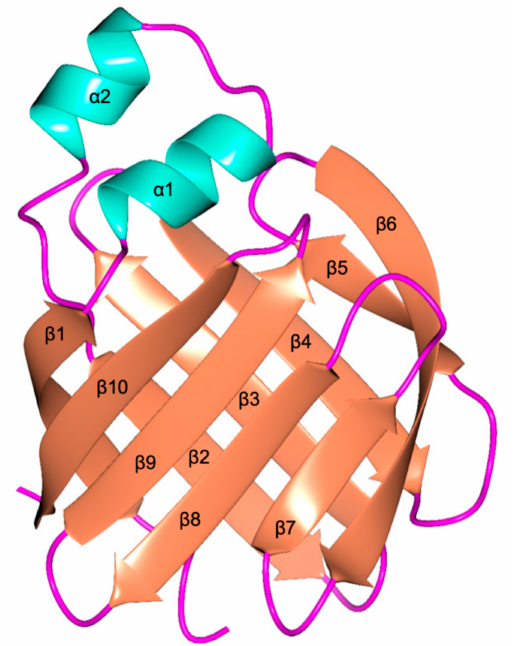
Figure 4. Cartoon representation of the tertiary structure of cL-BABP. α -helices are colored in coral, β -sheets in cyan, and loops in